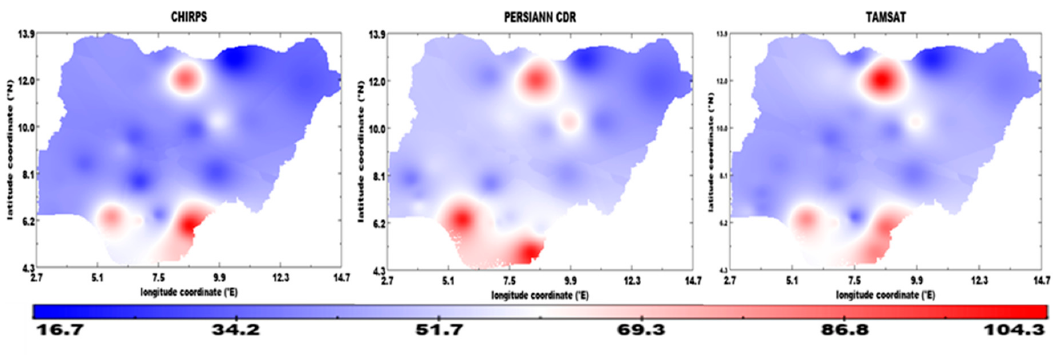
Figure 8. Root mean square error (RMSE) of mean JJAS rainfall.